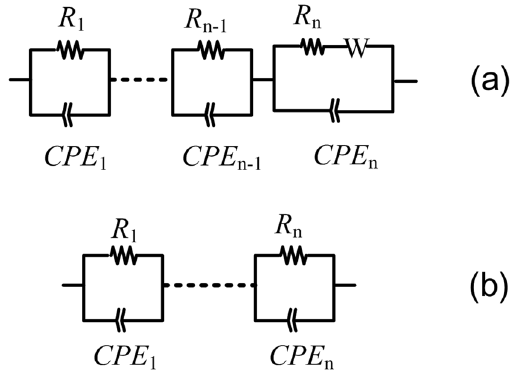
Figure 6. Equivalent circuits to fit the impedance data of BiT and BiT-A under ( a ) N 2 and ( b ) air/O 2 . “ R ”, “ CPE ” and “ W ” denote resistance, constant-phase element and Warburg impedance, respectively.